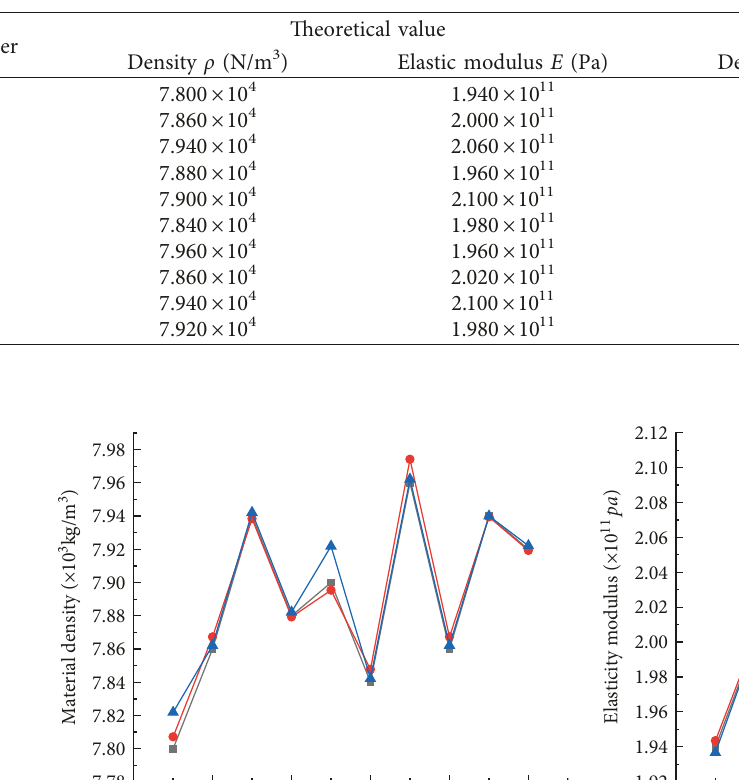
Table 6: Test results of GRNN.